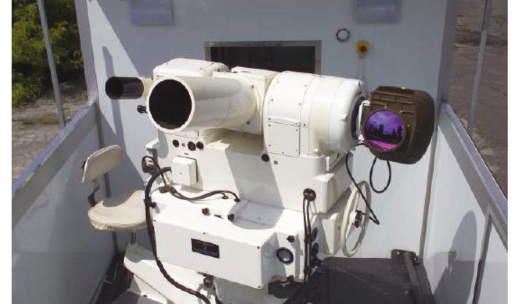
Figure 1: EOTS cinetheodolite on the operating post.